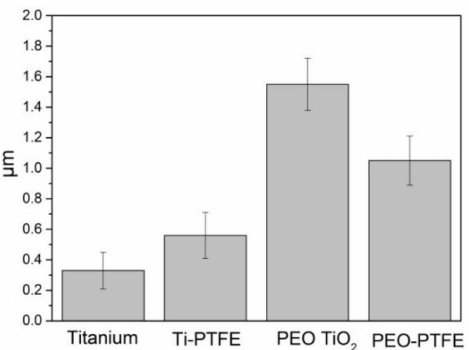
Figure 5. Surface roughness (Ra) of titanium substrate, Ti-PTFE coating, PEO TiO 2 coating and PEO–PTFE composite